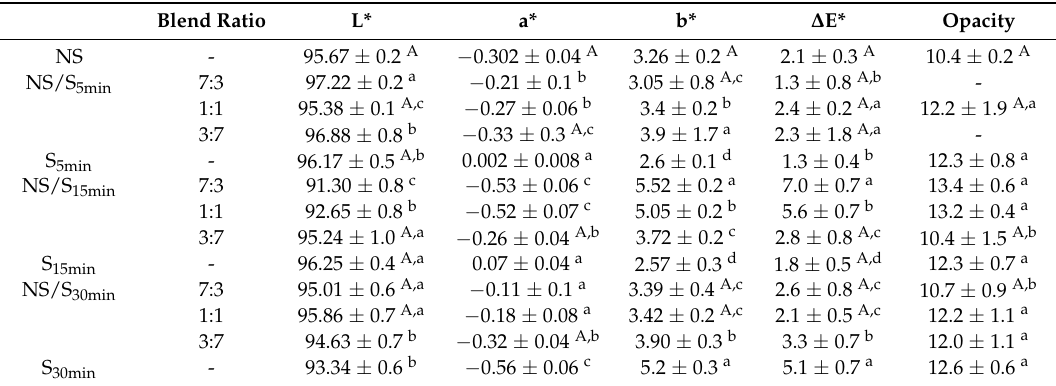
Table 2. Effect of nanosized chitosan (S) incorporation to the chitosan solution (NS) at different blend ratios on blend films color characteristics—a*, b*, L*, ∆ E*, and